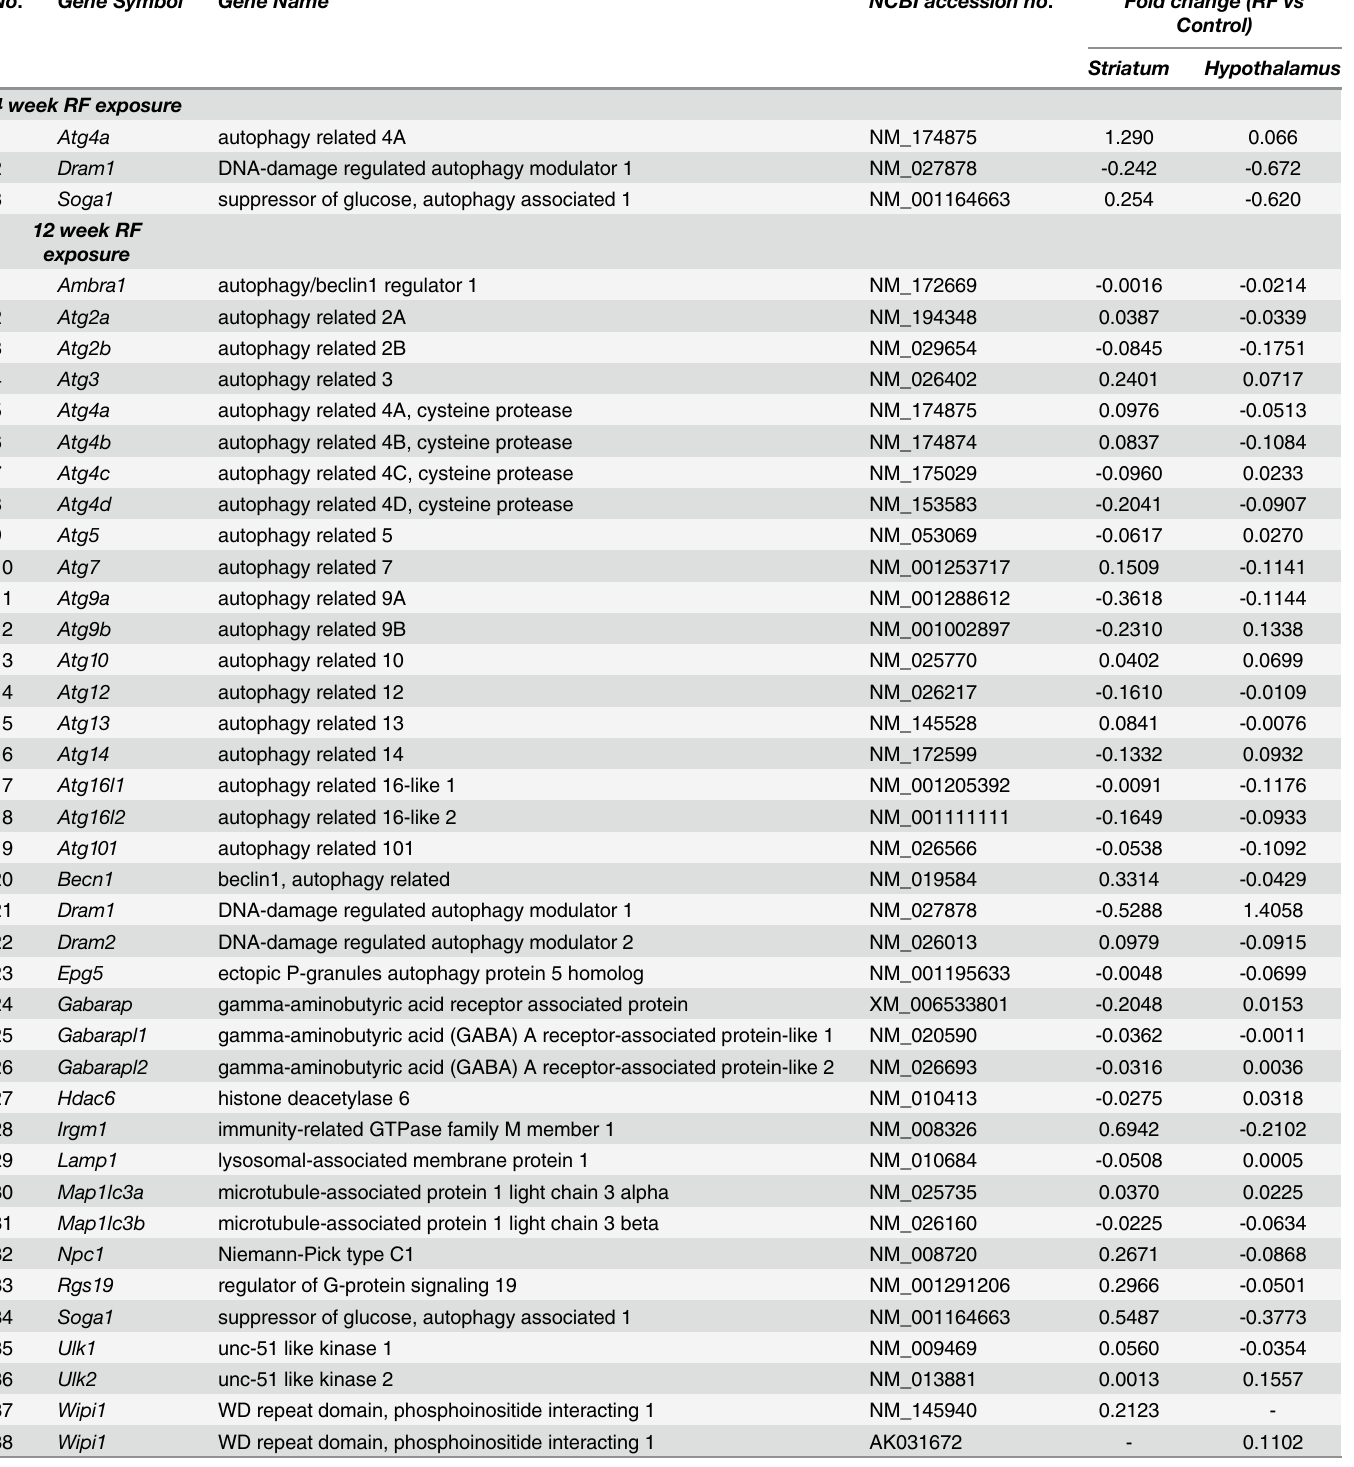
Table 1. Microarray analysis of autophagy-related gene expression in the striatum and hypothalamus of mice after 835MHz radiofrequency (RF) exposure for 4 or 12 weeks. No